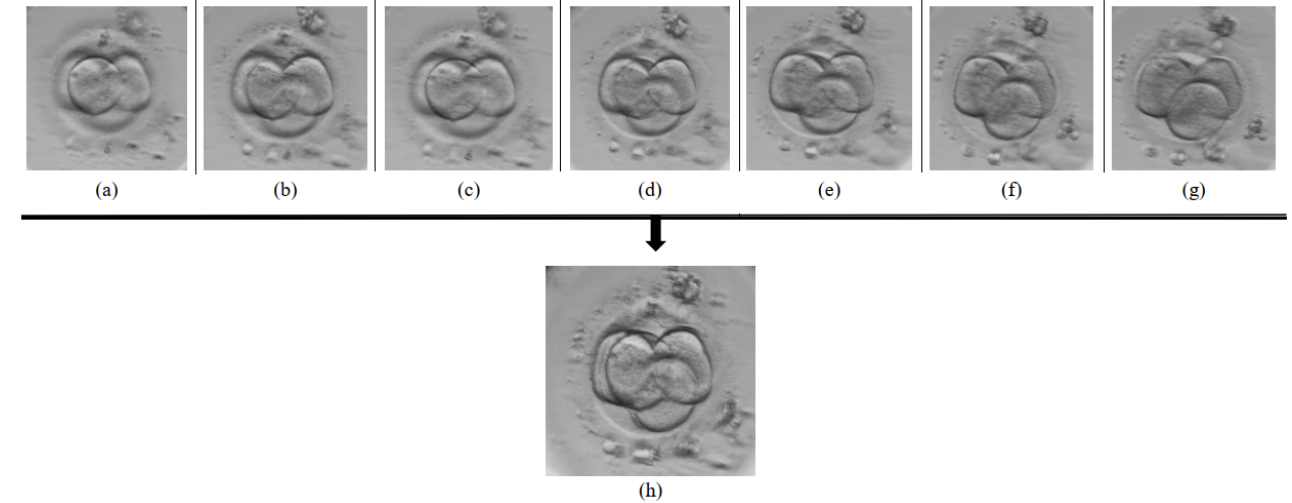
Figure 6. A fused 4-cell embryo image ( h ) generated from seven focal stack images ( a – g